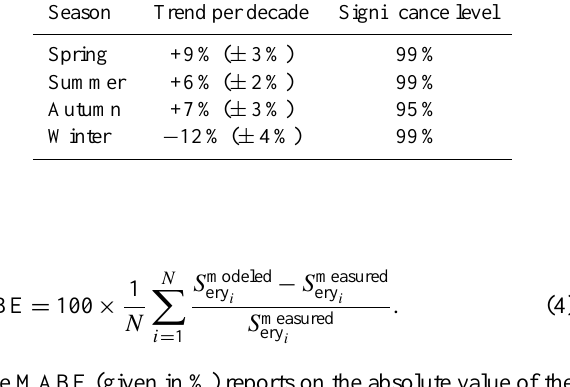
Table 2. Seasonal trends of erythemal UV doses (1991–2013). Season Trend per decade Significance